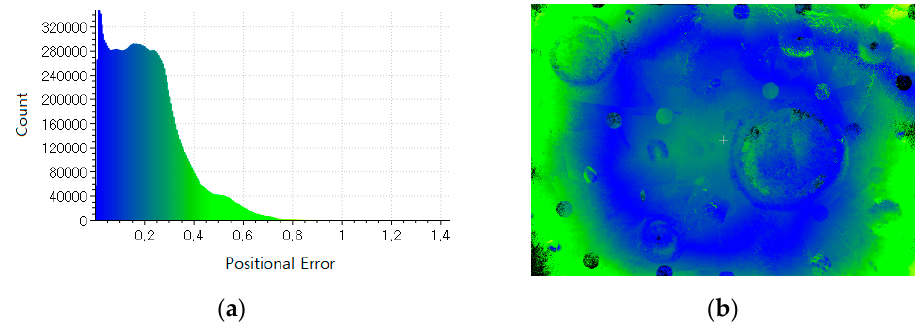
Figure 10. Positional error assessment to measured point-clouds (identical magnitude of a positional error from blue to yellow-green in both sub-figures): ( a ) positional error histogram; ( b ) positional error distribution.